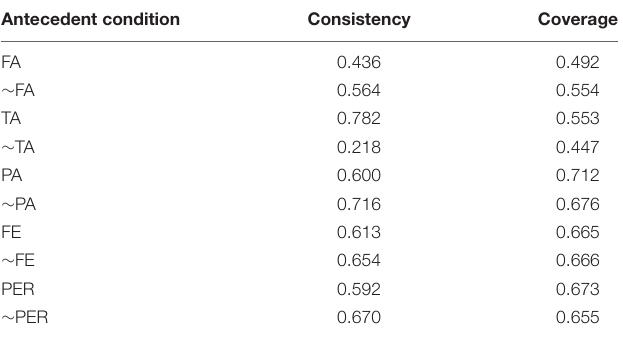
TABLE 3 | Analysis of the necessary conditions.